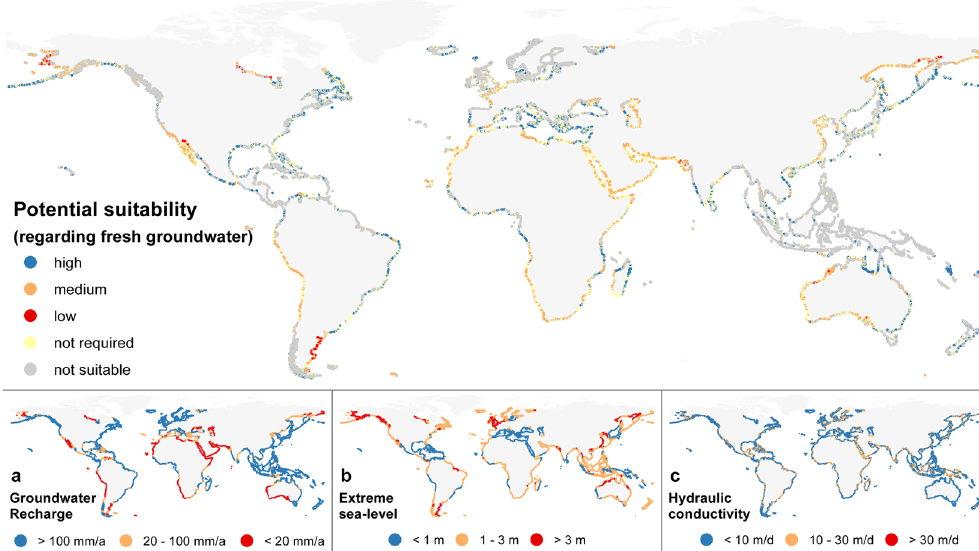
Figure 13. Global map of the potential suitability (high, medium, low) of eroding sandy shores for the growth of coastal fresh groundwater resources by large beach nourishments, based on the combination of global suitability maps for ( a ) groundwater recharge, ( b ) extreme sea-levels, ( c ) and coastal erosion (see Table 1).